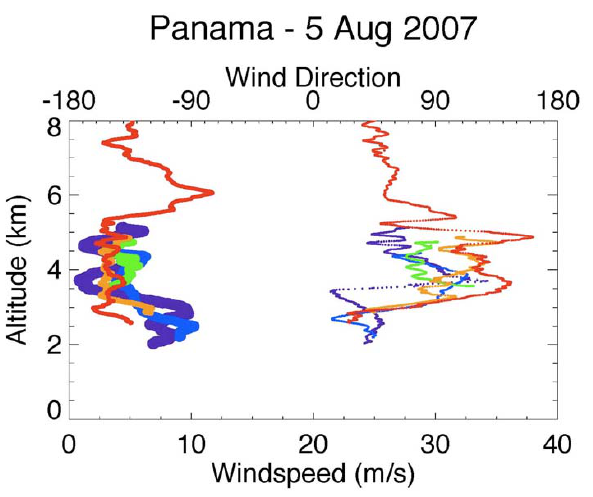
Fig. 10. The change in potential temperature from the first to the last ascent vs. altitude for the flight of 5 August 2007.